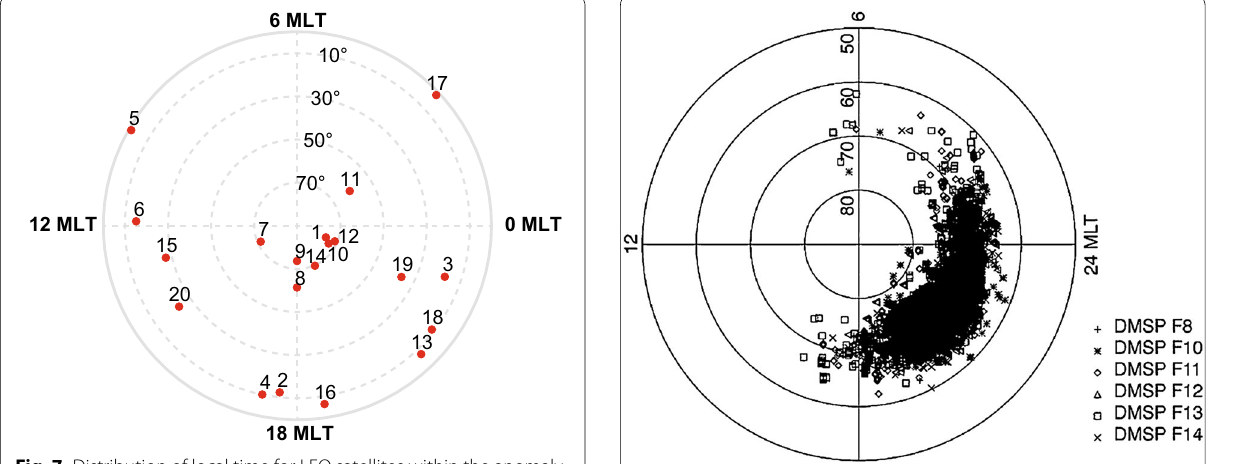
Fig. 7 Distribution of local time for LEO satellites within the anomaly